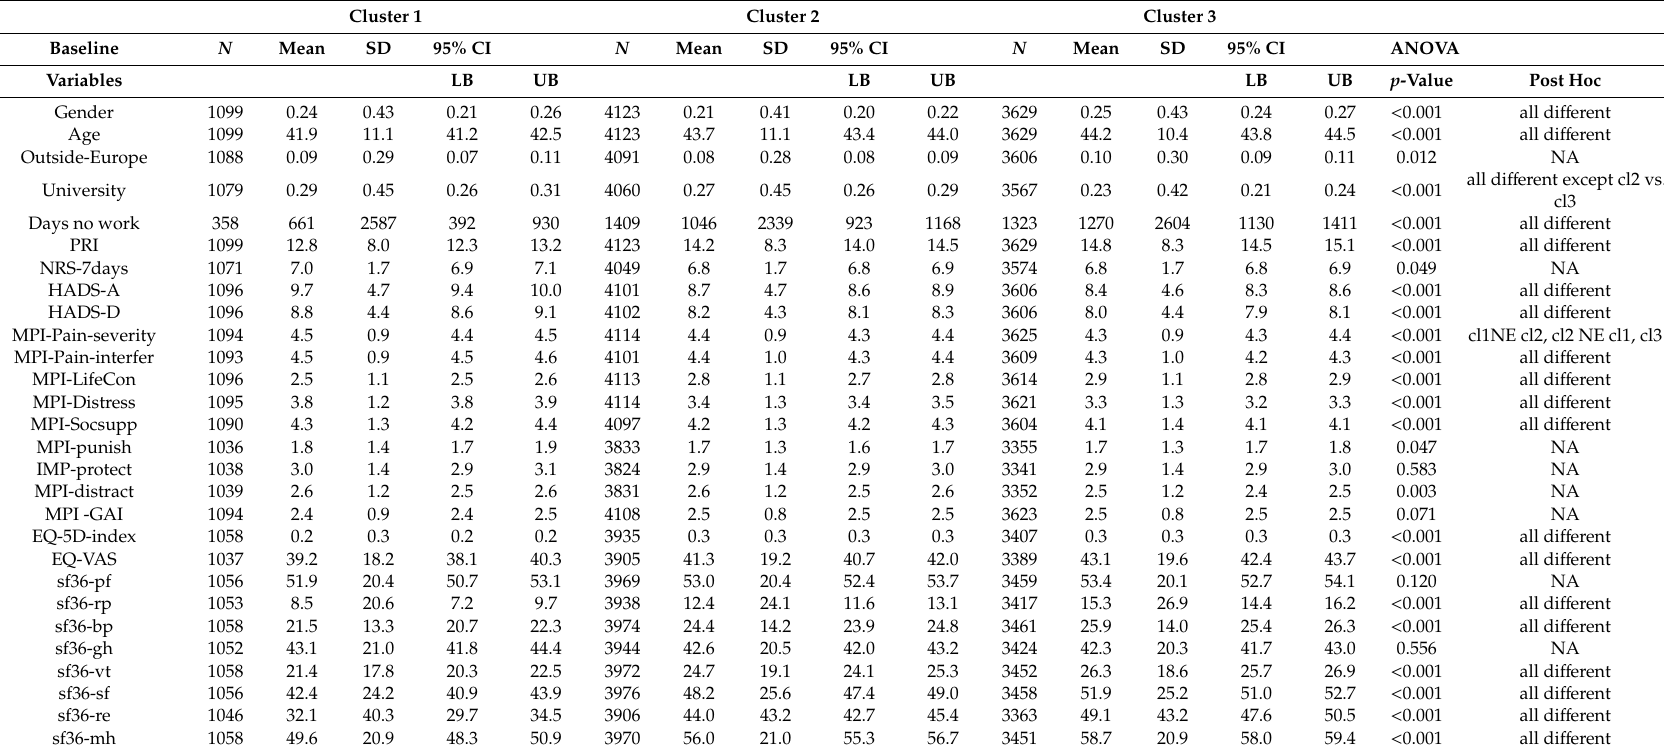
Table 9. Pre-IMMRP values for the three clusters based on MIS obtained at 12-month